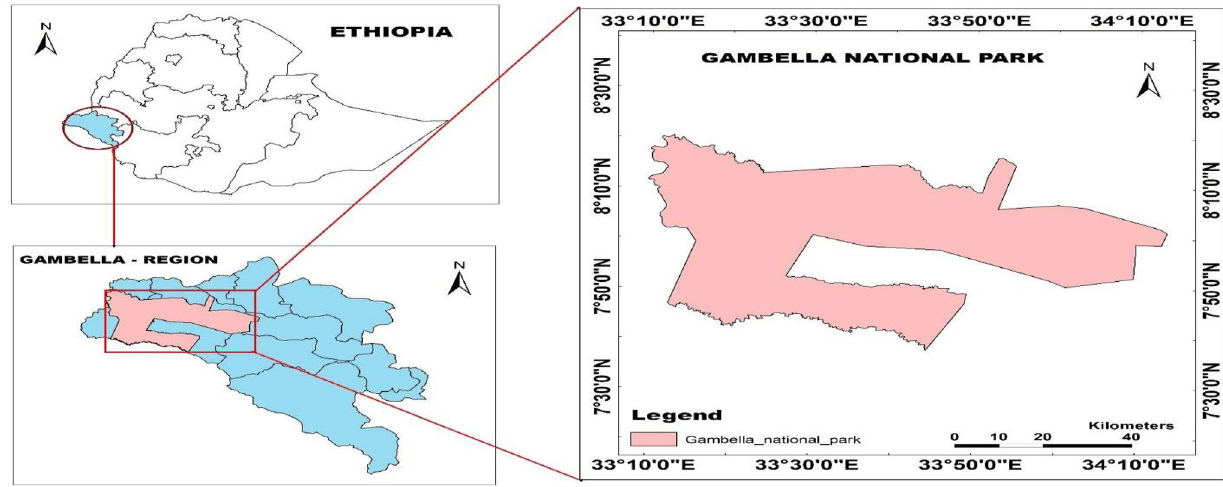
Fig. 1 Location Map of